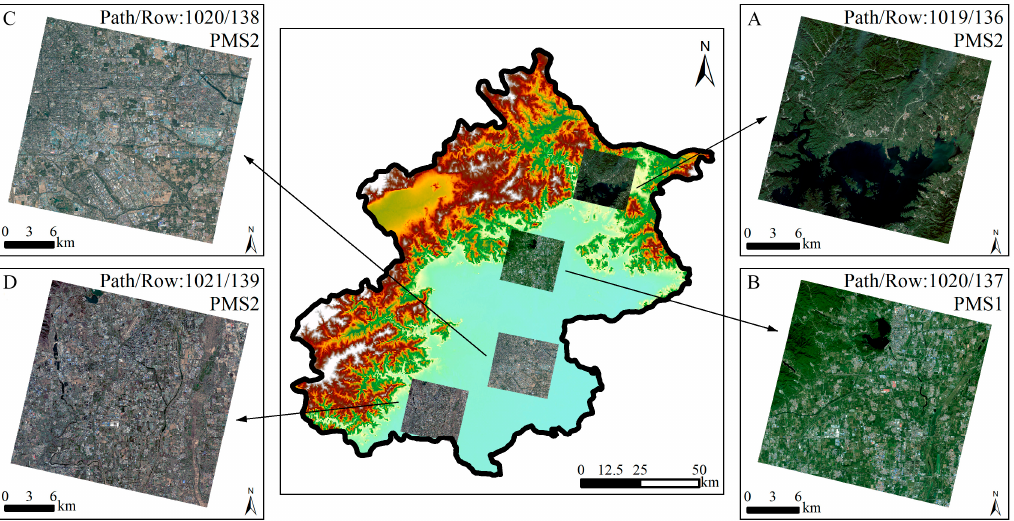
Figure 7. Four typical testing images (R: Band 3; G: Band 2; B: Band 1) ( A – D ) from north to south were used to assess accuracy in this study. The four images included mountain, plain, urban, and rural areas.